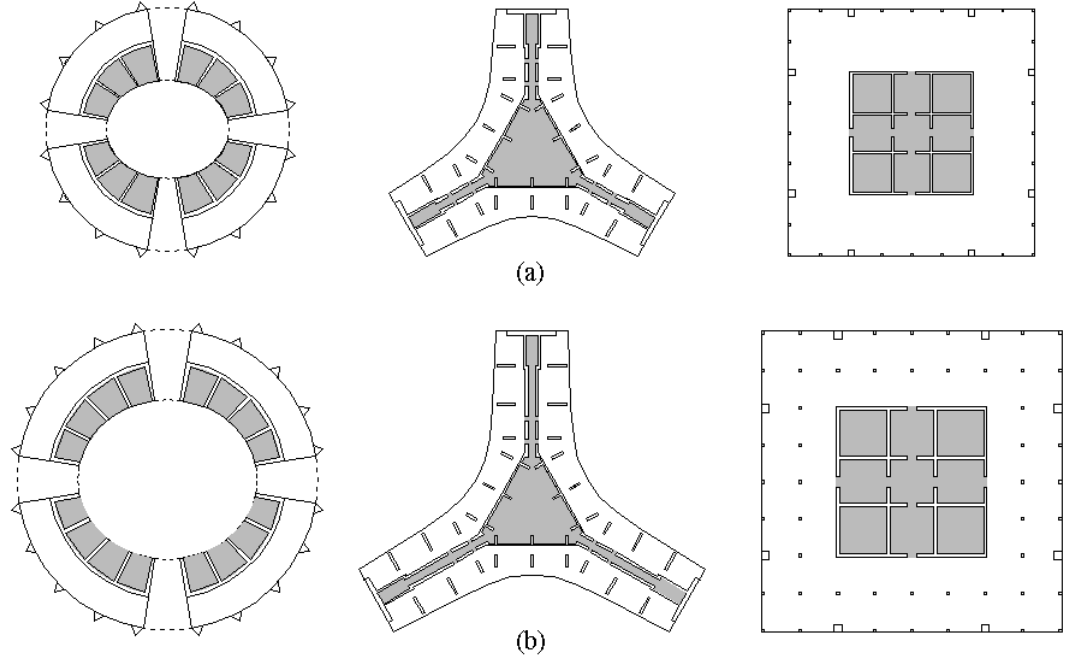
Figure 15. ( a ) Simplified structural plans for the Nakheel Tower (left), Kingdom Tower (middle), and a Rectangular Box Form Tower (right), about 1000 m tall and 100 m wide, with a slenderness of 10:1. ( b ) Simplified structural plans for the taller version of the Nakheel Tower (left), Kingdom Tower (middle), and Rectangular Box Form Tower (right), about 1200 m tall and 120 m wide, to keep the slenderness of